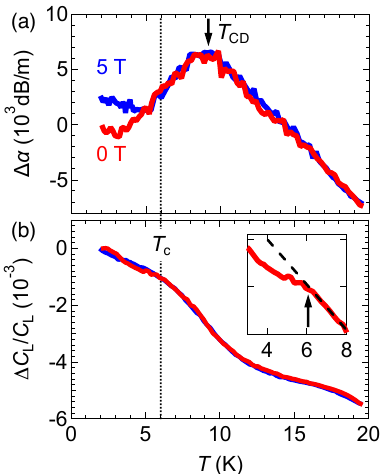
Figure 5. ( a , b ) Low-temperature elastic properties, ( a ) the relative change in the ultrasonic attenuation ∆ α , and ( b ) the elastic constant ∆ C L / C L , as a function of temperature [45]. The red and blue curves are the data at 0 and 5 T, respectively. The arrow in ( a ) indicates the transition temperature of the charge ordered state T CO . The inset in ( b ) is the enlarged plot around T c . To emphasize the superconducting transition, a linear extrapolation estimated from the behavior of the normal state is shown as a dashed line in the